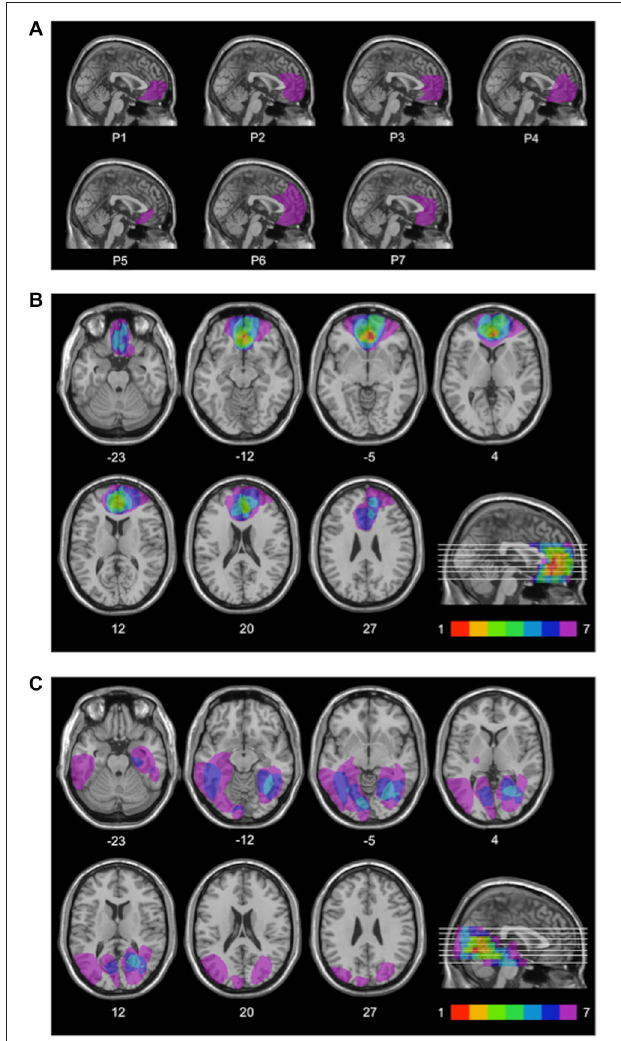
FIGURE 1 | Lesion locations . Mesial view of the standard Montreal Neurological Institute brain showing the individual lesions in the rACC group (A) , lesion overlap in the rACC group (B) , and lesion overlap in the BDC group (C) each projected on the same seven axial slices and on the mesial view of the standard Montreal Neurological Institute brain. In (B) and (C) , levels of axial slices are marked by white horizontal lines on the mesial views of the brain, and z -coordinates of each axial slice are given. Color bars indicate the number of overlapping lesions. In each axial slice, the left hemisphere is located on the left side. In the rACC group, maximal lesion overlap occurs in the rostral portion of the anterior cingulate cortex and adjoining ventromedial prefrontal